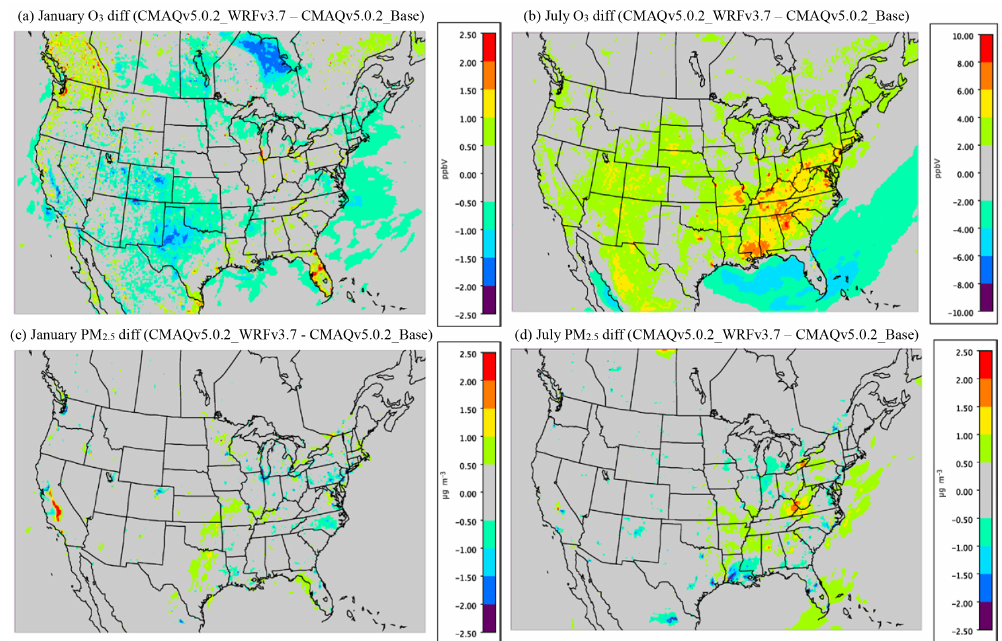
Figure 1. Monthly average difference in O 3 (ppbv) for (a) January and (b) July and PM 2 . 5 (µgm − 3 ) for (c) January and (d) July between CMAQv5.0.2 using WRFv3.4 (CMAQv5.0.2_Base) and CMAQv5.0.2 using WRFv3.7 (CMAQv5.0.2_WRFv3.7) (CMAQv5.0.2_WRFv3.7–CMAQv5.0.2_Base). Note that the scales between each plot may